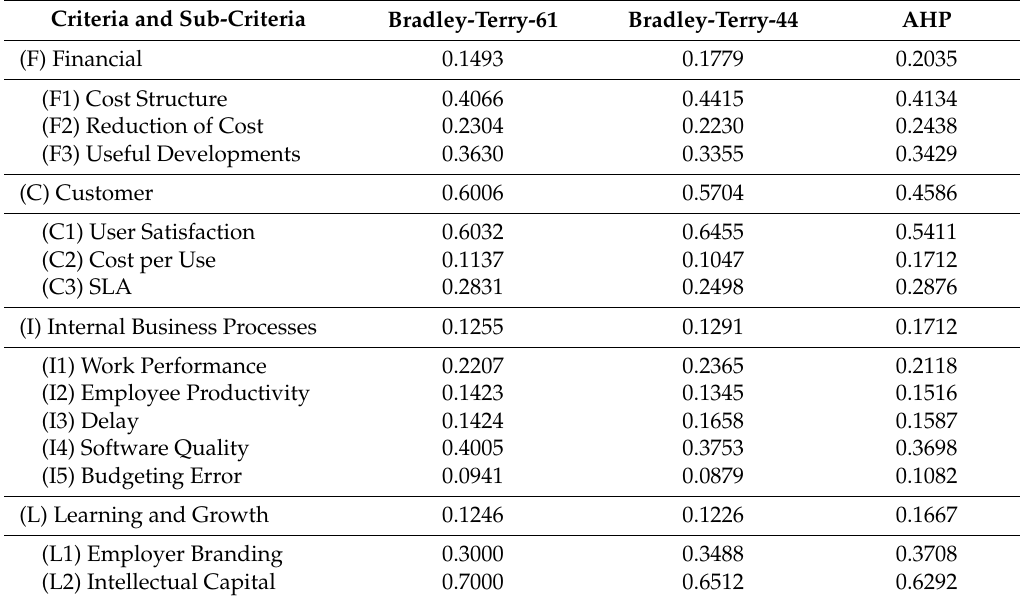
Table 12. Bradley-Terry local weights compared with the Analytic Hierarchy Process method (AHP). Criteria and Sub-Criteria